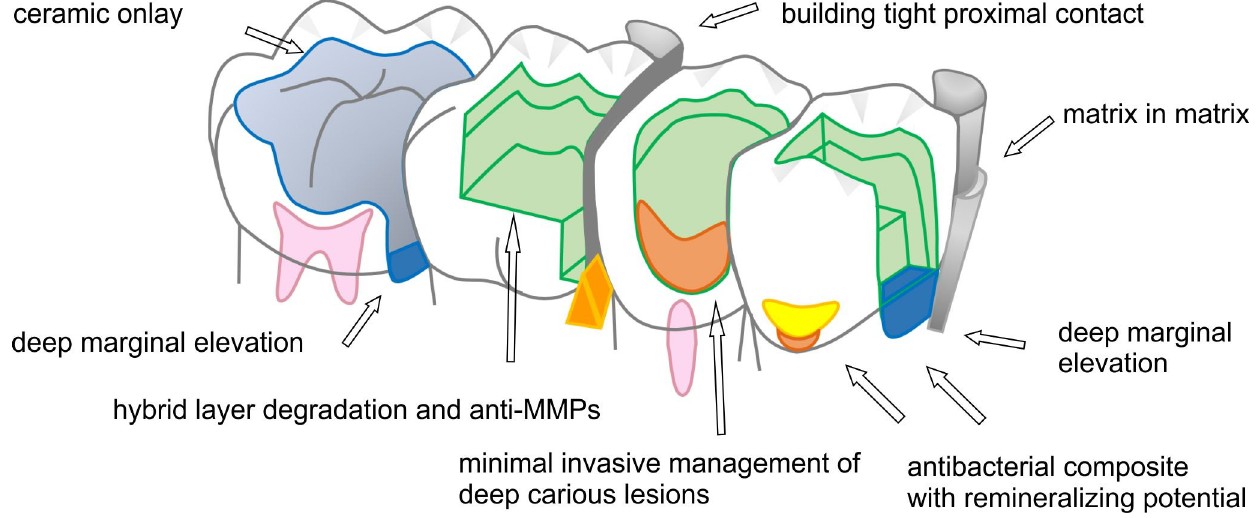
Figure 2. Schematic drawing summarizing most common sites of occurrence of recurrent caries and residual caries.